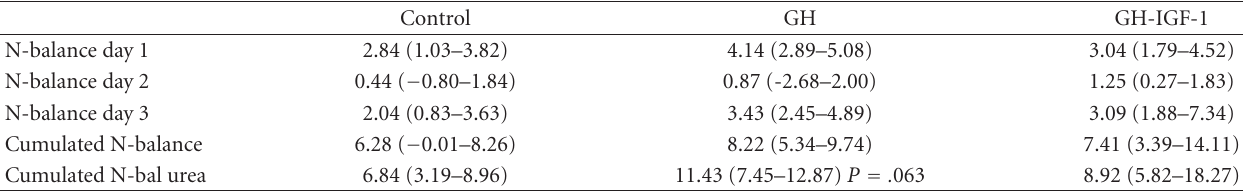
Table 4: Nitrogen balance during the postoperative period (g N). P < .10 are given as numbers indicating di ff erences between the groups. Values are given as medians and quartiles.